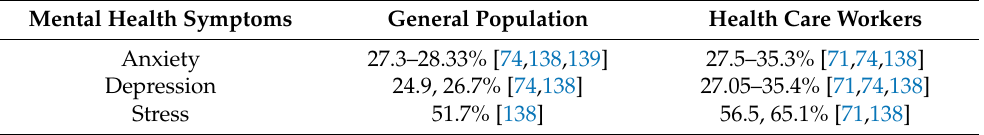
Table 7. Comparison of the prevalence of anxiety, depression and stress in the general population and health care workers during the